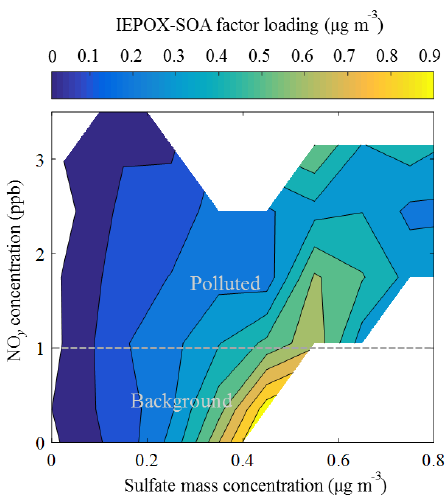
Figure 8. Contours of IEPOX-SOA factor loading for sulfate and NO y concentrations. The plotted data were recorded during local af- ternoon (12:00–16:00 local time; 16:00–20:00UTC). Typical tran- sition between regimes of background and polluted conditions for the region downwind of Manaus are approximately represented by the dashed gray